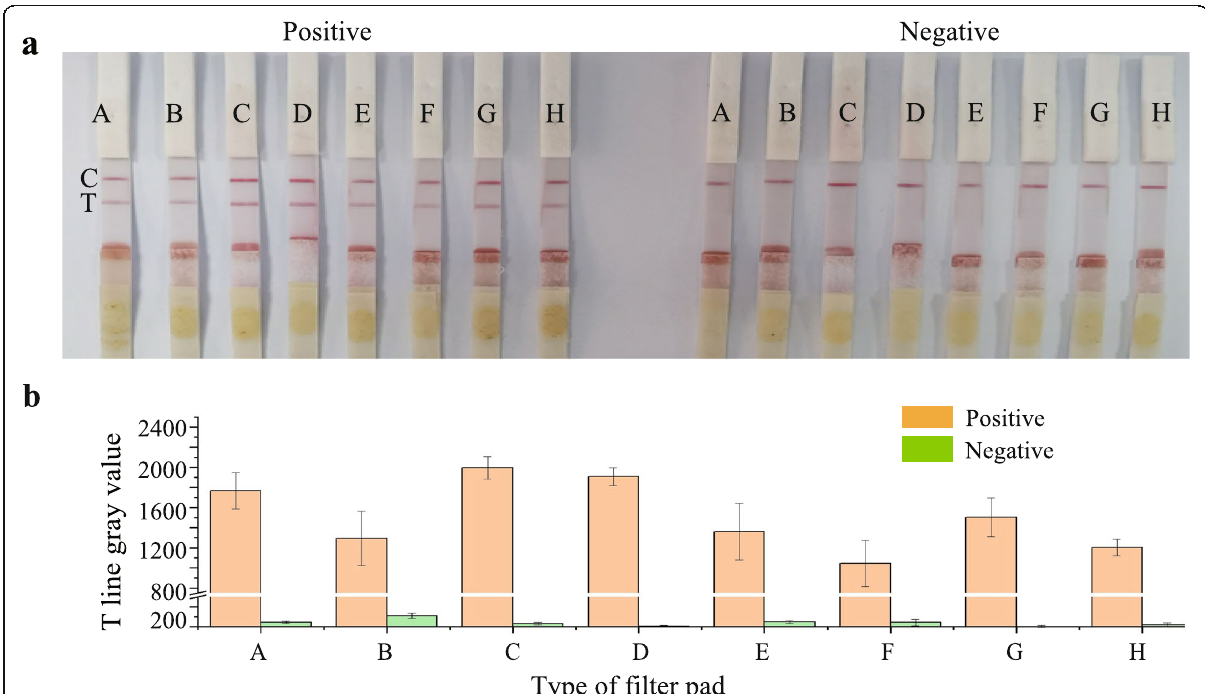
Fig. 3 Optimization of filter pads added to the LBs-LFIA. a Images of the positive and negative sample results using different filter pads. b Gray value analysis of T